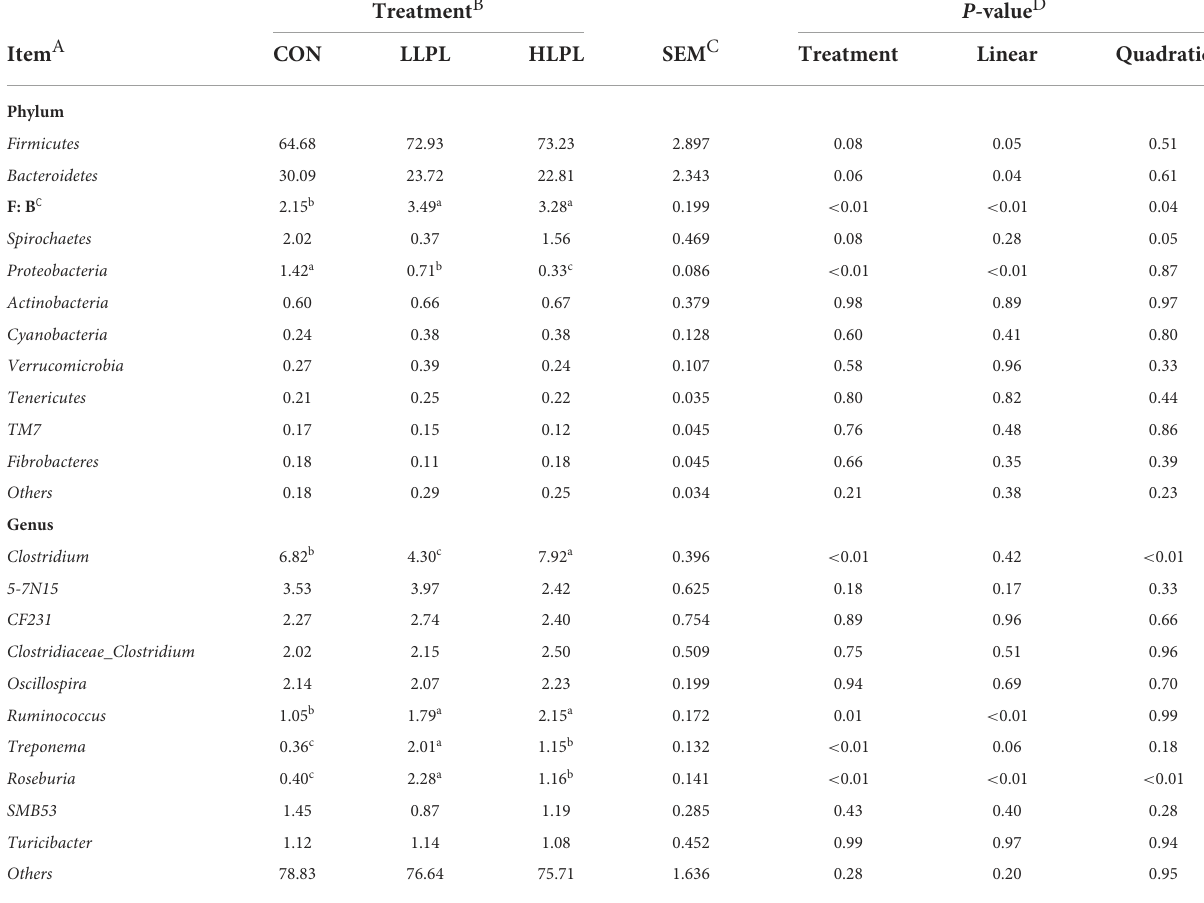
TABLE 5 Effects of dietary lysophospholipids on the relative abundance (%) of fecal